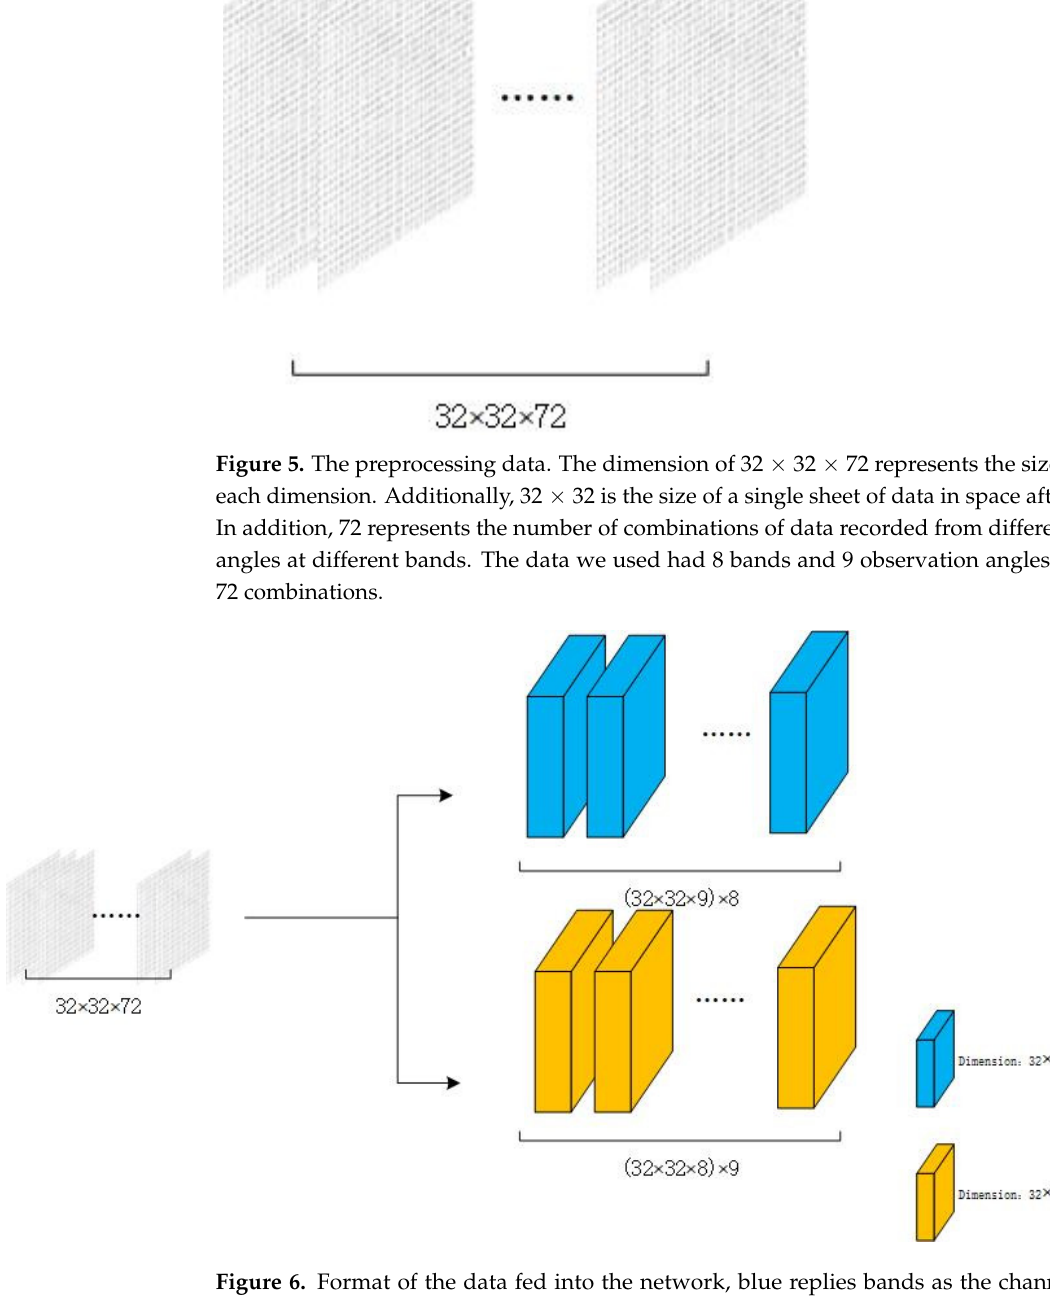
Figure 6. Format of the data fed into the network, blue replies bands as the channel and yellow replies angles as the channel.